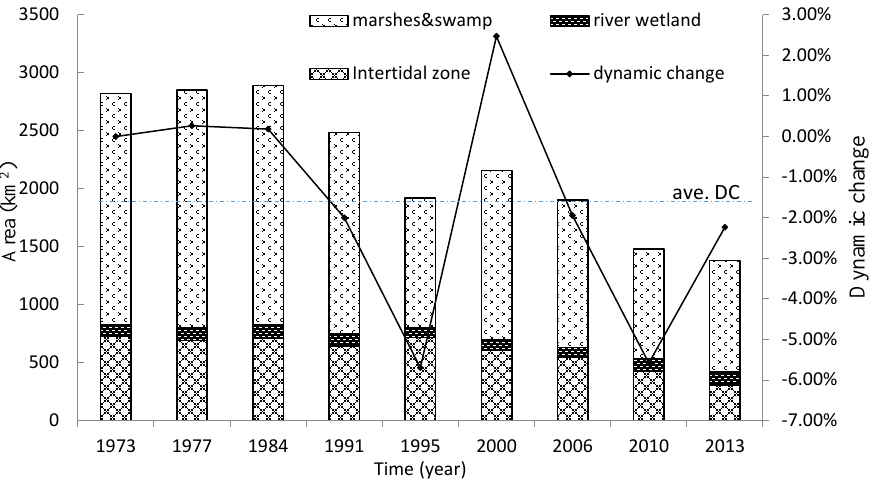
Figure 7. Accumulation histogram of natural wetland area and dynamic change. The blue line is the average dynamic change (ave. DC).